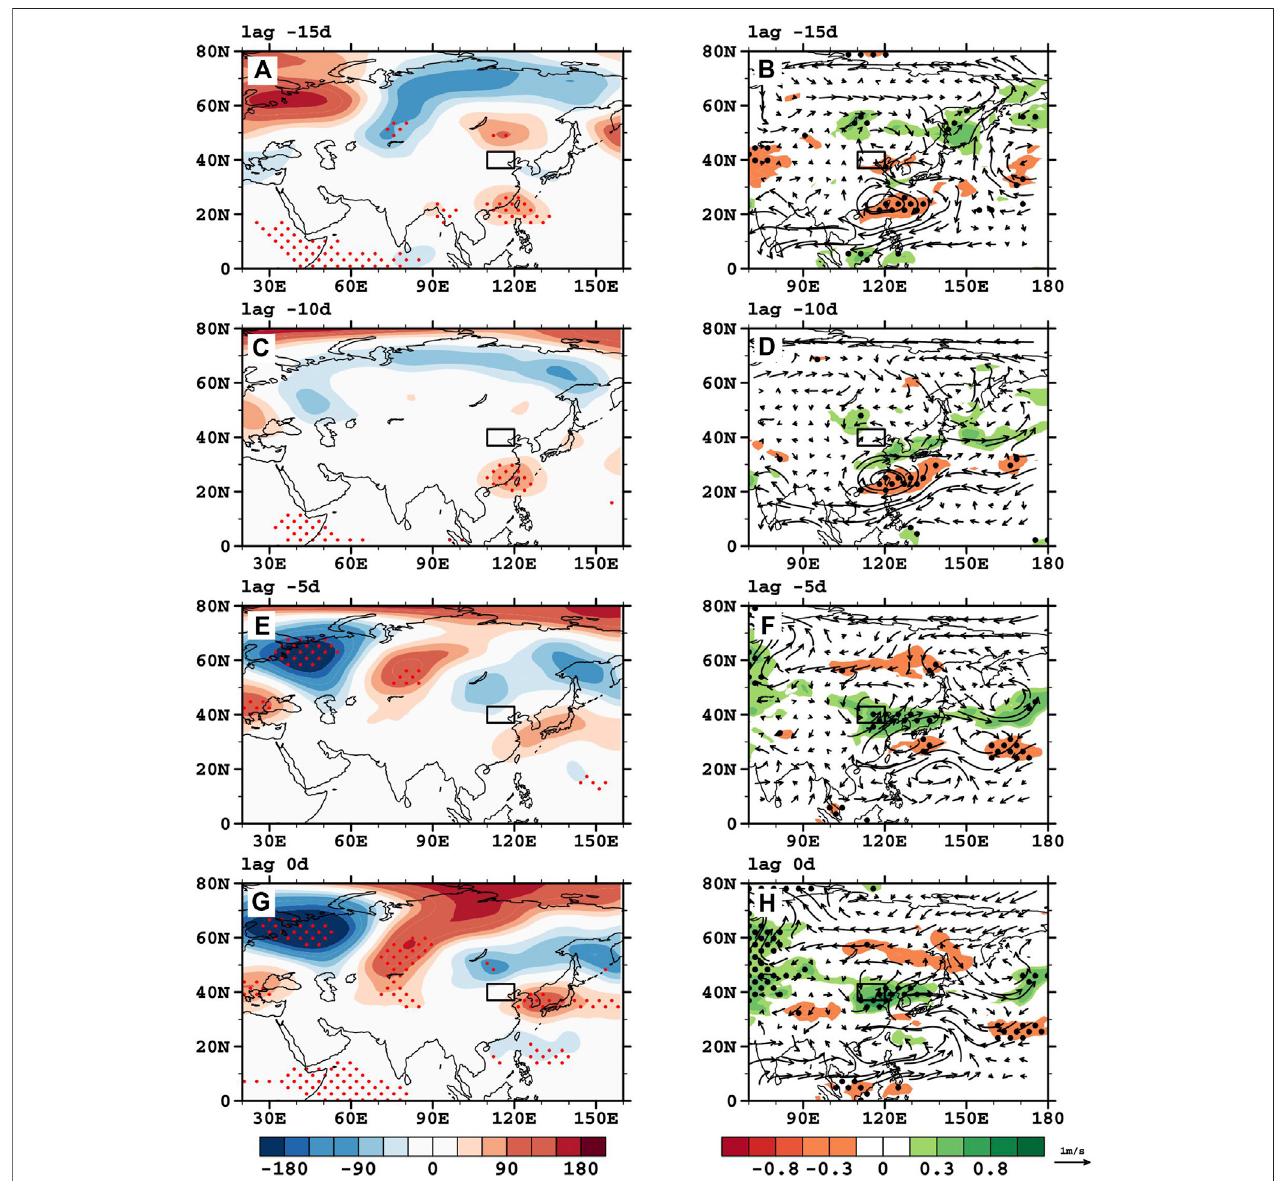
FIGURE10| 30 – 60-day fi ltered geopotential height(shading, unit: gpm) fi eldsat 500 hPa (A,C,E,G) and speci fi chumidity(shading, unit: g · kg − 1 ) and wind (vector, unit: m · s − 1 ) fi elds at 850 hPa (B,D,F,H) during day 15, 10, 5, and 0 prior to the onset of type 2 PEPEs. Red and black dotted areas indicate a 95% con fi dence level. The rectangle indicates North